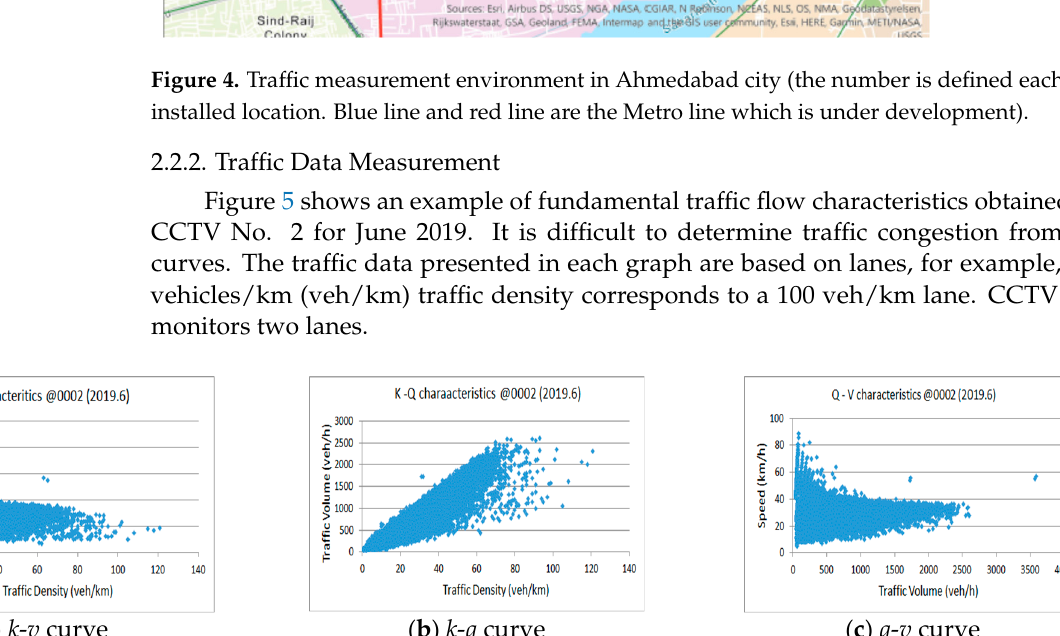
Figure 5. Example of fundamental traffic flow characteristics monitored by CCTV No. 2.